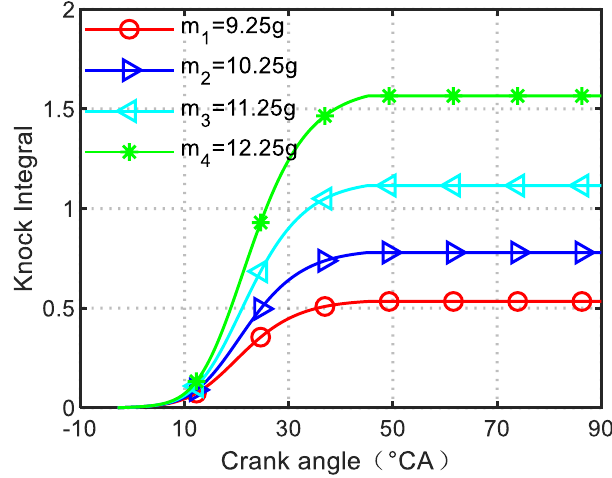
Figure 12. Knock integral under different natural gas intake.